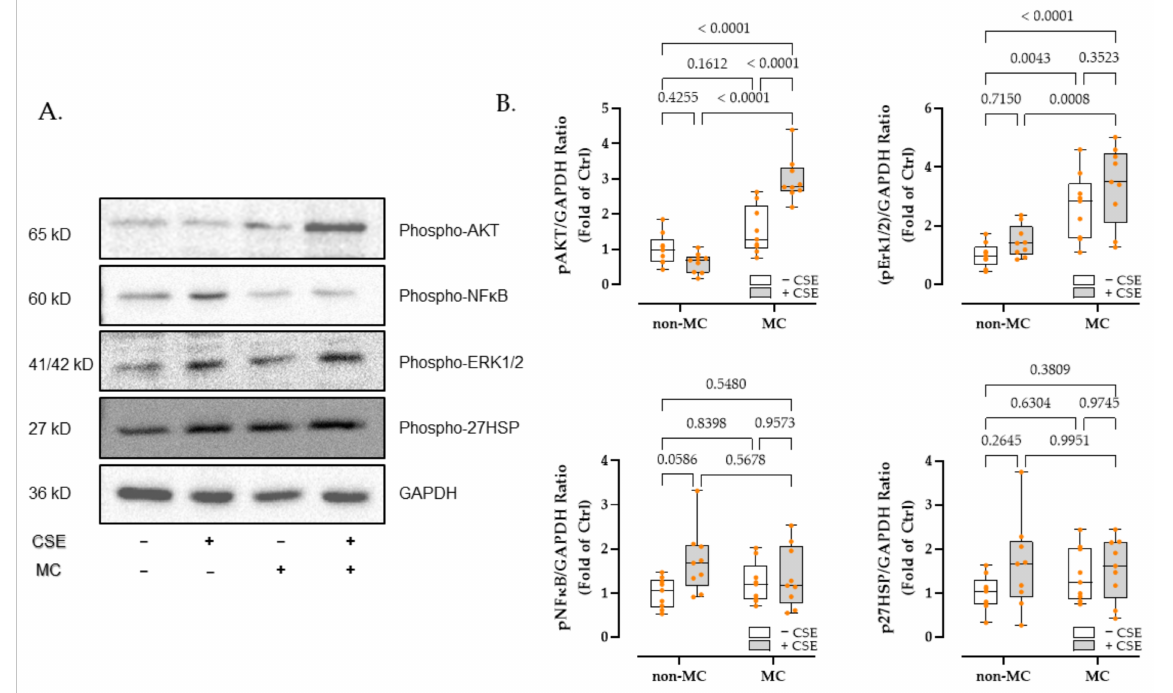
Figure 4. Western blots showed 100 µ A MC exposure intensified PI3K-Akt and MAPK signal- ing in CSE-injured HaCaT Cells. Densitometer readings and related information are provided in Supplementary Table S4. Original Western blot images are provided in Supplementary Figure S2. ( A ) Representative Western blot. ( B ). ( Upper left ) 3% CSE reduced p-Akt by 38.72%, meanwhile, ex- posure to the 100 µ A MC significantly intensified the expression of p-Akt by 299.90% in the presence of CSE. 100 µ A MC alone did not significantly enhance the p-Akt expression. ( Upper right ) p-Erk 1/2 100 µ A exposure significantly upregulated the p-Erk 1/2 both in the presence or absence of 3% CSE. ( Lower ) no significant changes in p-NF κ B and p-27HSP were observed. Quantification of den- sitometries of the band (as x-fold of Ctrl) was performed via ImageJ Software. GAPDH expressions were used as loading controls. N = 3, n = 3. Non-parametric two-way ANOVA followed by Tukey’s multiple comparison test was performed to compare the